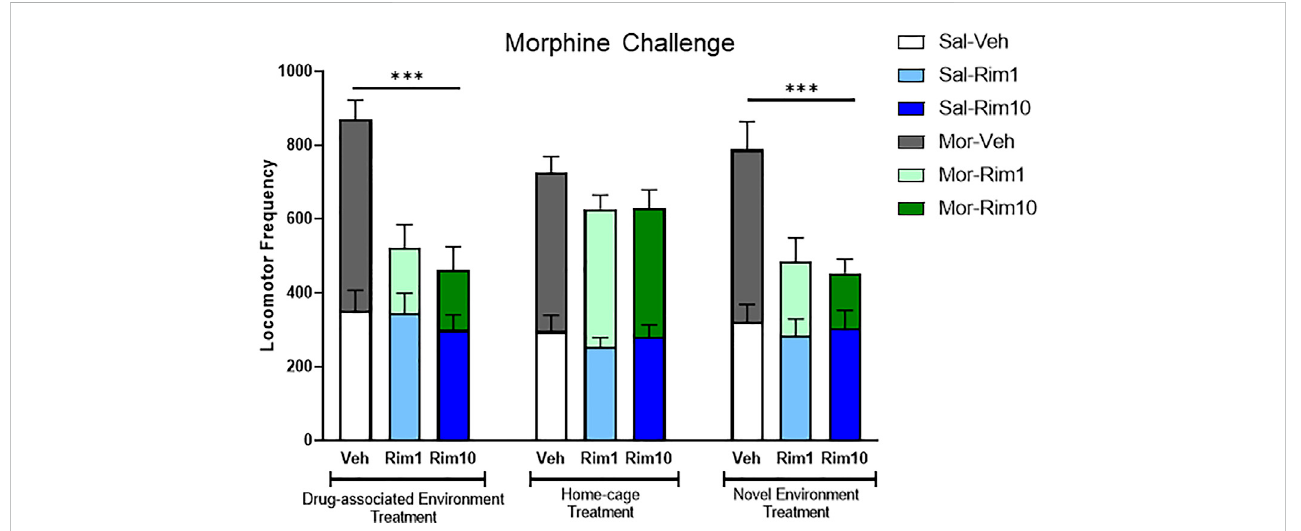
Comparison of the Morphine Challenge data and analyses for all three experiments. Treatment with rimonabant (Rim 1 and Rim 10, 1 and 10 mg/kg, respectively) blocked the expression of morphine-induced behavioral sensitization when animals received treatment in the drug-associated environment (open- fi eld, Experiment 1) or in the novel environment (activity box, Experiment 3), but not when treatment was given in the home-cage (Experiment 2). Veh: vehicle. Data are reported as mean ± SEM and data from saline vs. morphine-sensitized animals are superimposed. *** p < 0.05 compared with the Mor- Veh group during within the same